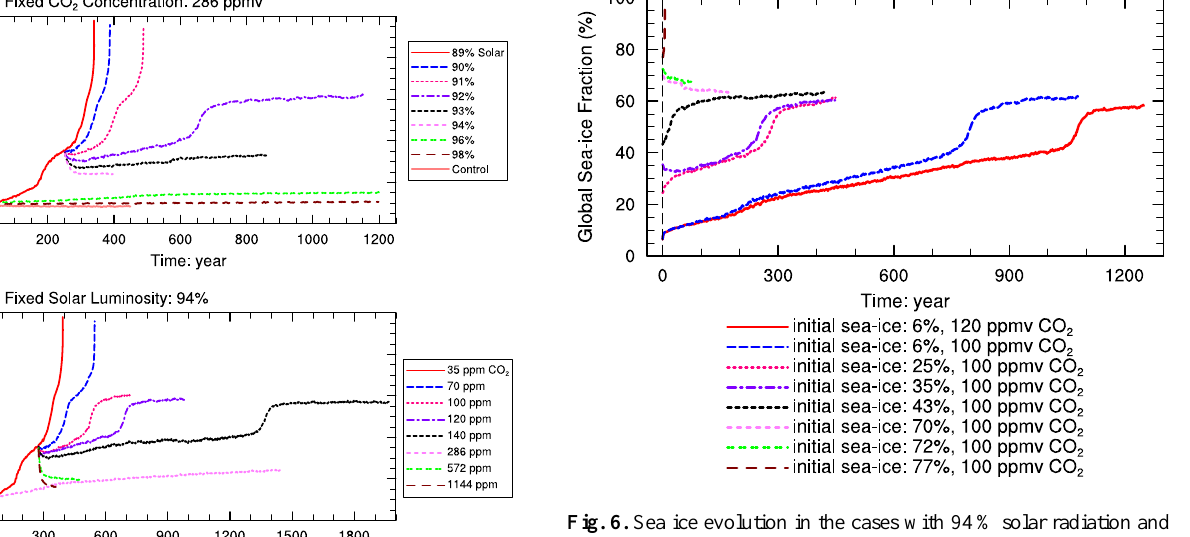
Fig. 6. Sea ice evolution in the cases with 94% solar radiation and 120 or 100ppmv CO 2 under different initial conditions. The eight experiments start from the present-day climate ( ∼ 6% sea ice), the 1401th year of the case with 94% solar radiation and 286ppmv CO 2 ( ∼ 25% sea ice, a quasi-equilibrium state), the 276th year of the case with 94% solar radiation and 35ppmv CO 2 ( ∼ 35% sea ice, a transient state, same as that in Fig. 5b), the 1326th year of the case with 94% solar radiation and 140ppmv CO 2 ( ∼ 43% sea ice, a quasi-equilibrium state), the 526th year ( ∼ 70% sea ice, a transient state), the 531th year ( ∼ 72% sea ice, a transient state) and the 536th year ( ∼ 77% sea ice, a transient state) of the case with 94% solar radiation and 70ppmv CO 2 ,